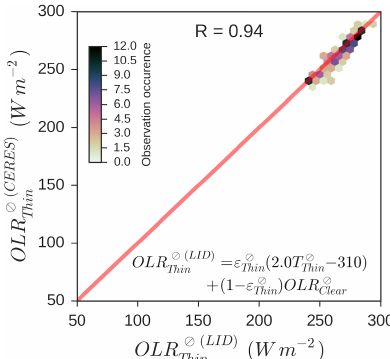
> 0 ◦ C, which could be liquid broken opaque clouds misclassified as thin Figure E5. As Fig. 6b but only with T (cid:11) thin